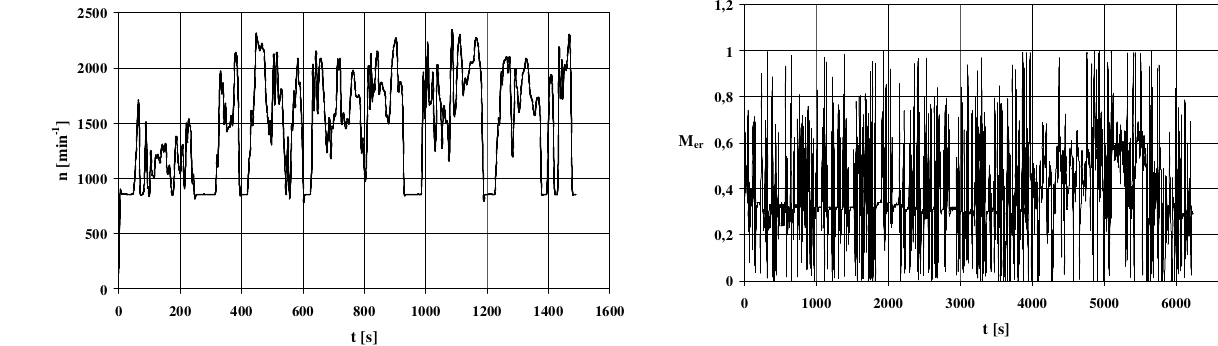
Fig. 2. Engine speed characteristic in the Malta test